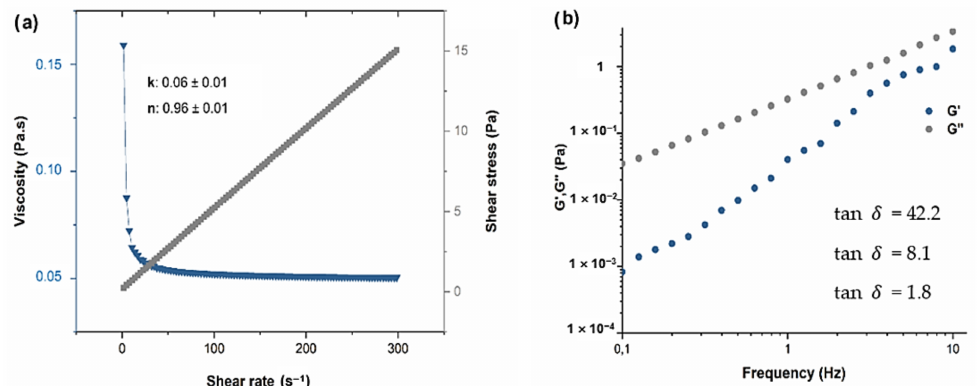
Figure 2. ( a ) Flow curve (gray symbols) and respective viscosity (blue symbols) of the chitosan optimized formulation (2% Ch + 2% GTE + 0.1% FO) in a shear rate range of 0 to 300 s − 1 under isothermal (25 ◦ C) conditions and its flow ( n ) and consistency ( k ) indexes; ( b ) Elastic modulus (blue symbols) and viscous modulus (grey symbols) as a function of frequency (0.1 to 10 Hz) under isothermal (25 ◦ C) conditions and tan δ at different frequencies for the formulation 2% Ch + 2% GTE + 0.1%